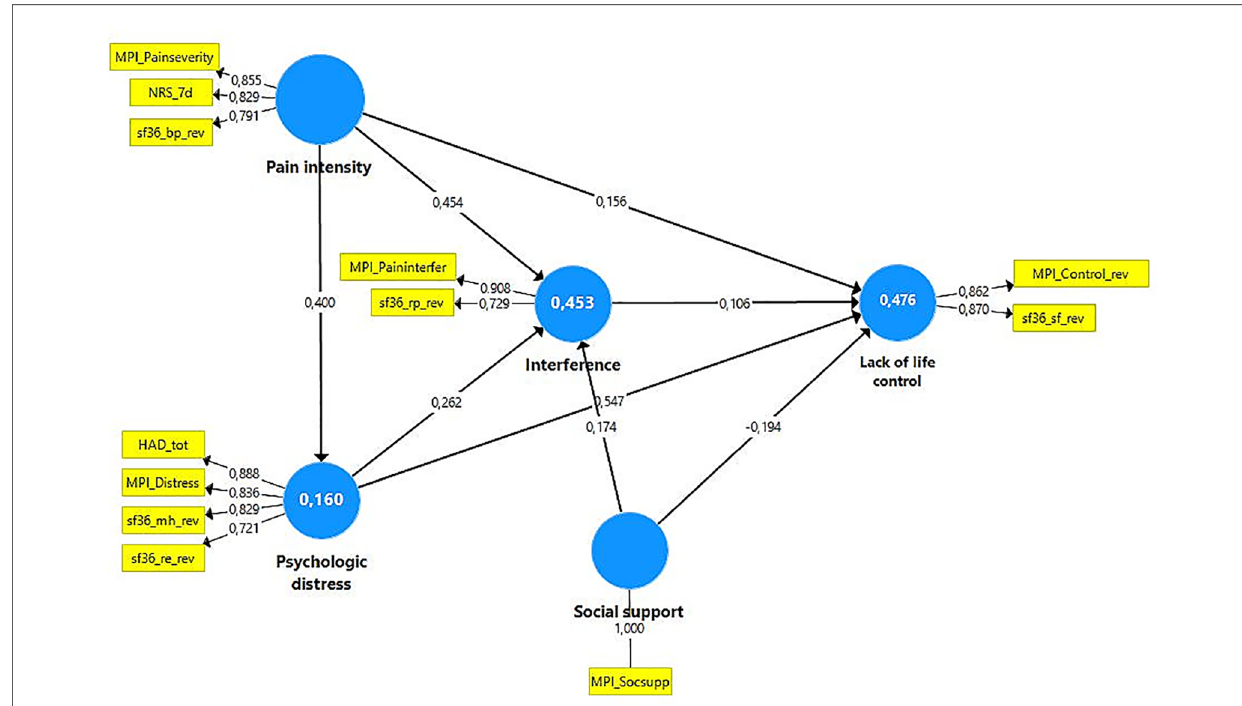
FIGURE 3 Model 2 for all subjects ( N =40,184). That is, if pain intensity affects psychological distress, model 1 is identical including loadings and path coef fi cients except for the arrow between pain intensity and psychological distress and R 2 for pain intensity then is 0.160. The blue circles show the constructs/latent variables. The yellow boxes show the indicators (re fl ective) for each construct/latent variable; the fi gure attached to the thin arrows show the loading. The thicker arrows show the suggested relations between the constructs, and the fi gure attached shows the path coef fi cient (direct effect). The explained variance ( R 2 ) is reported within the relevant constructs. Note that some of the MPI variables and all sf36 variables were revised (indicated with _rev in the variable name) so that high values indicated a troublesome/negative situation. NRS_7d, Pain intensity according to a numeric rating scale; HAD, The Hospital Anxiety and Depression Scale; HAD-tot, sum of the two subscales of HAD; MPI, Multidimensional Pain Inventory; MPI_Paininterfer, MPI Pain interference; MPI_Painseverity, MPI Pain severity; MPI_Socsupp, MPI Social support; sf36, The Short Form Health Survey; sf36_rp,